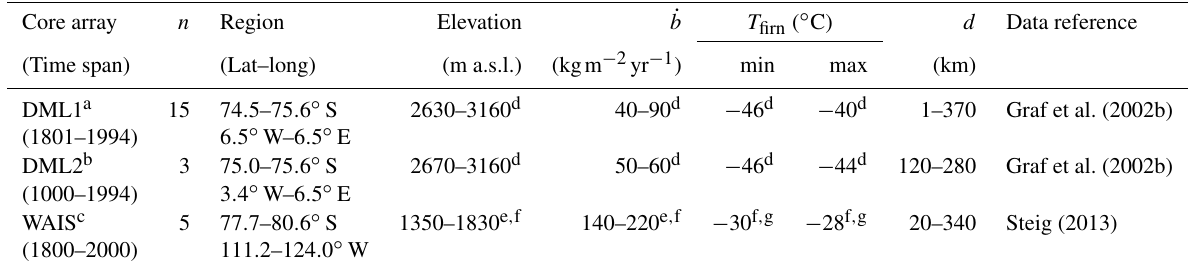
Table 1. Overview of the firn cores (sorted into three data sets) used in this study. Listed are the covered time spans of each core array (in yr CE), the number of records in each array ( n ), the region of origin (latitude–longitude range), the range of site elevations, local accumulation rates ( ˙ b ) and 10m firn temperatures ( T firn ) reported in the original publications, and the range of intercore distances ( d ). The range of WAIS firn temperatures is based on ERA-Interim annual mean anomalies (Dee et al., 2011) with respect to the WDC2005A